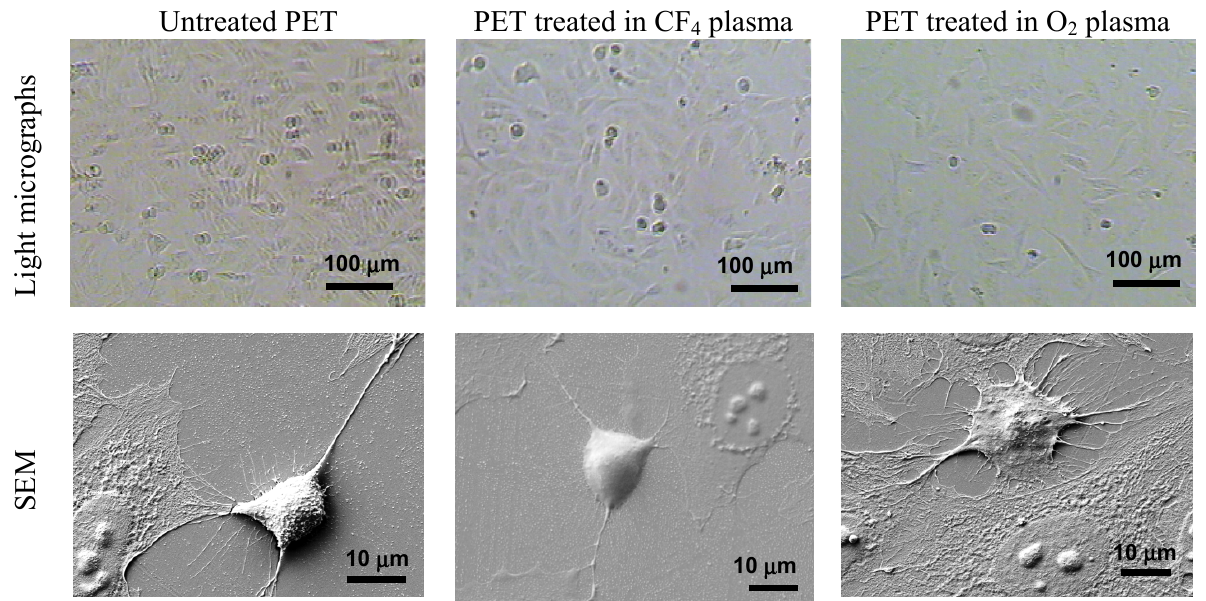
Figure 15. HOS cell adhesion and morphology on the PET polymer surface after plasma treatment, as measured using light microscopy and SEM analysis after 1 day of incubation.